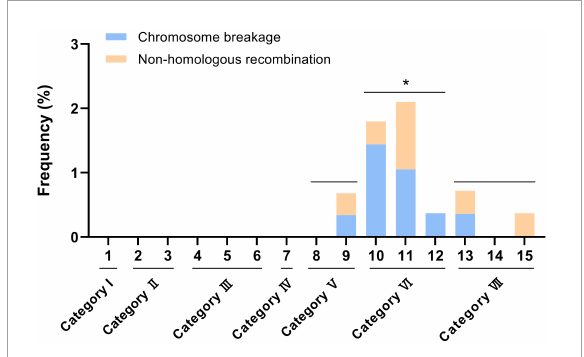
FIGURE6 Frequency of broken and non-homologous recombination 5A chromosomes. Numbers in horizontal axis indicate the 15 hybrid combination. * p < 0.05 ( t